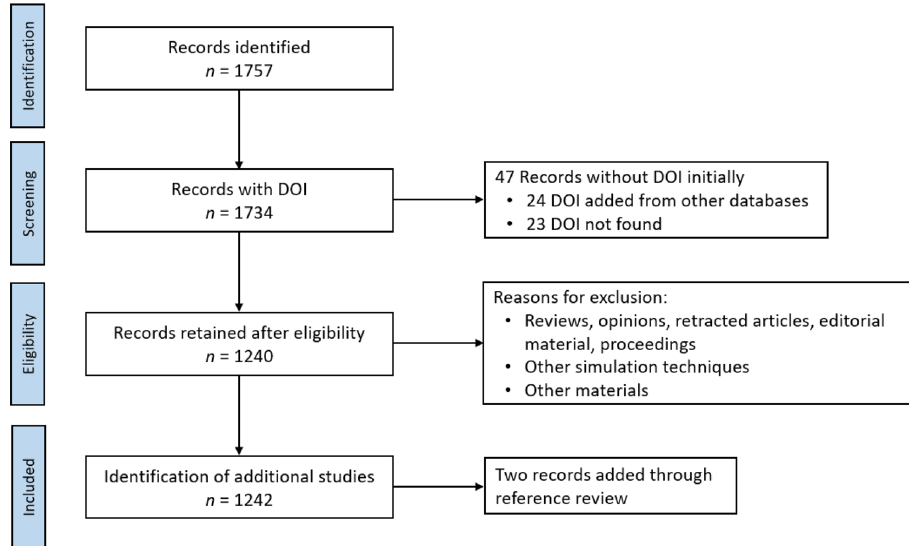
Fig. 1 PRISMA flow diagram for the document selection